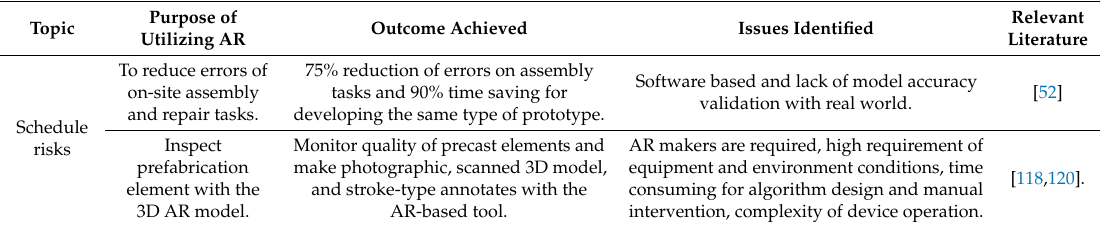
Table 10. Research topics, purpose of augmented reality (AR) adoption, and outcomes achieved in